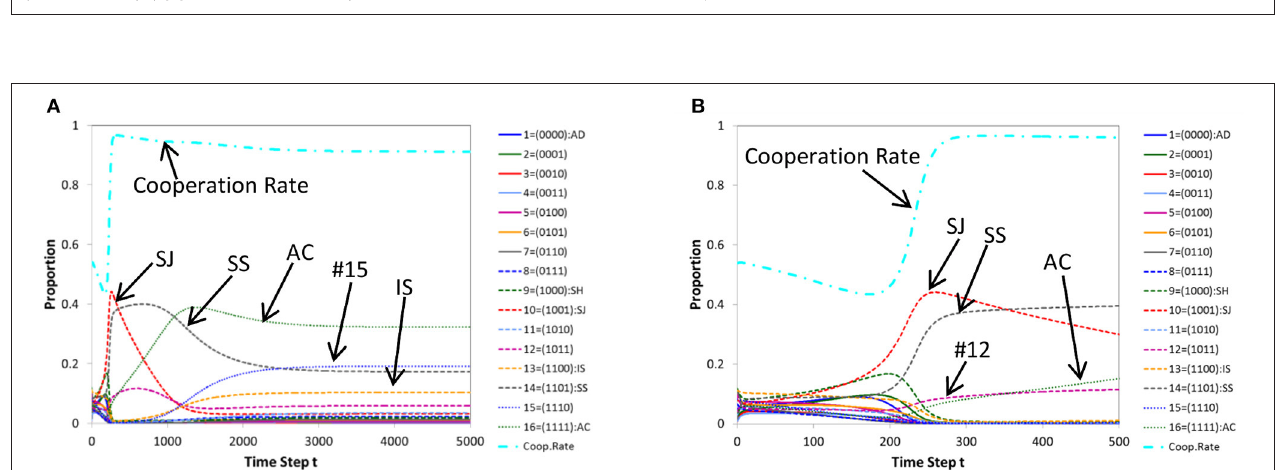
FIGURE 3 | A typical pattern of time evolution of norms’ frequencies and the cooperation rate in the population generated by genetic algorithm (A) and its initial part (the first 30 steps) (B) for a case where cooperation is achieved. Parameters: c = 1, b = 7, µ = 0.01, dt = 1.